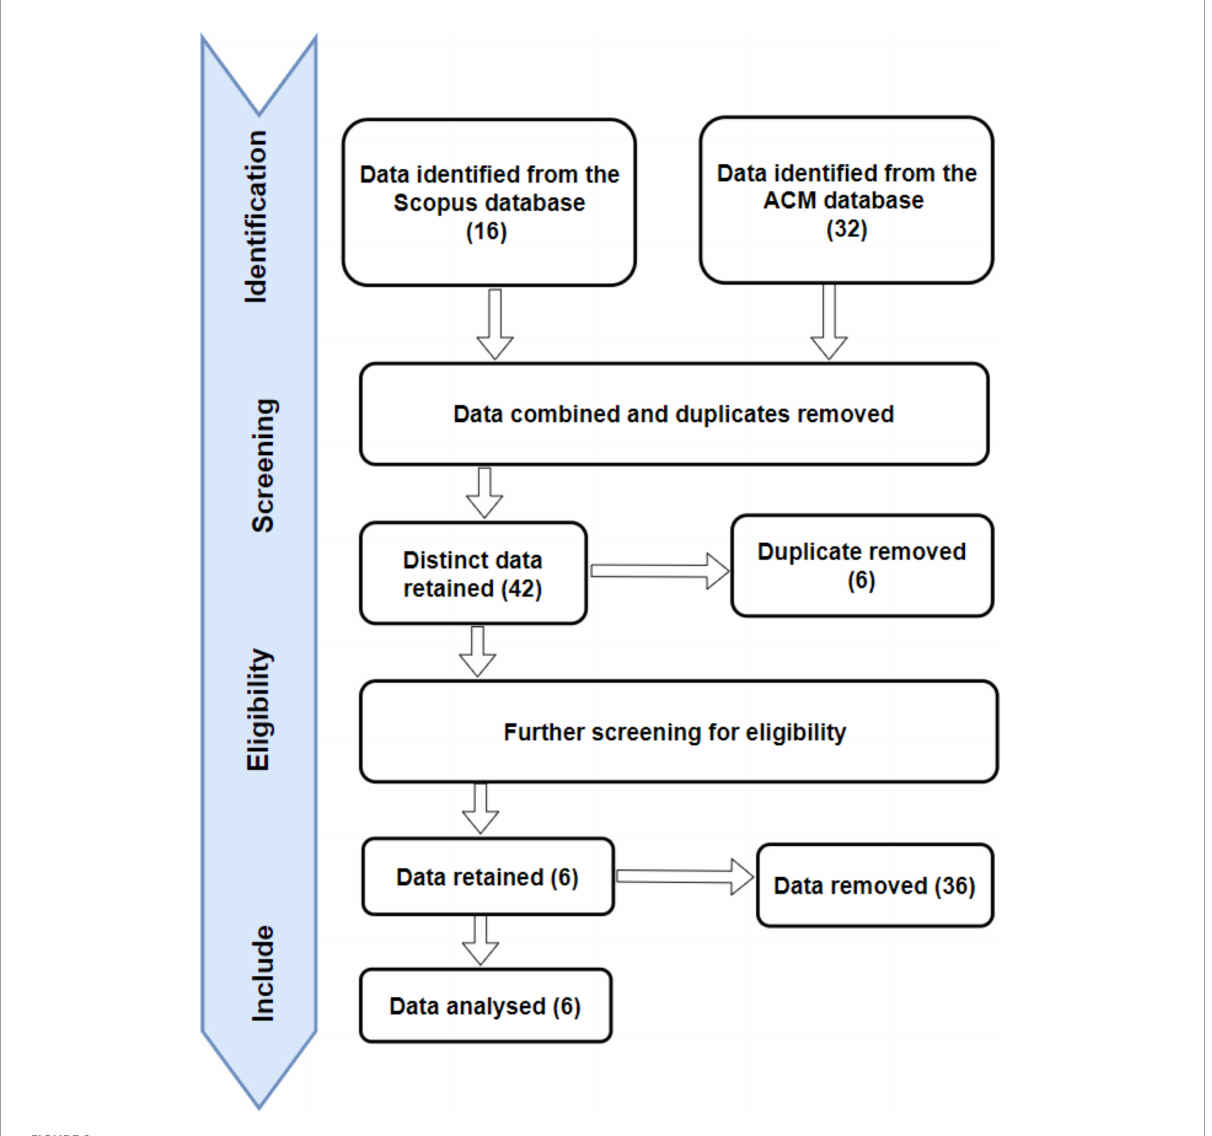
FIGURE2 PRISMA diagram including the data collection and screening procedure (Moher et al.,